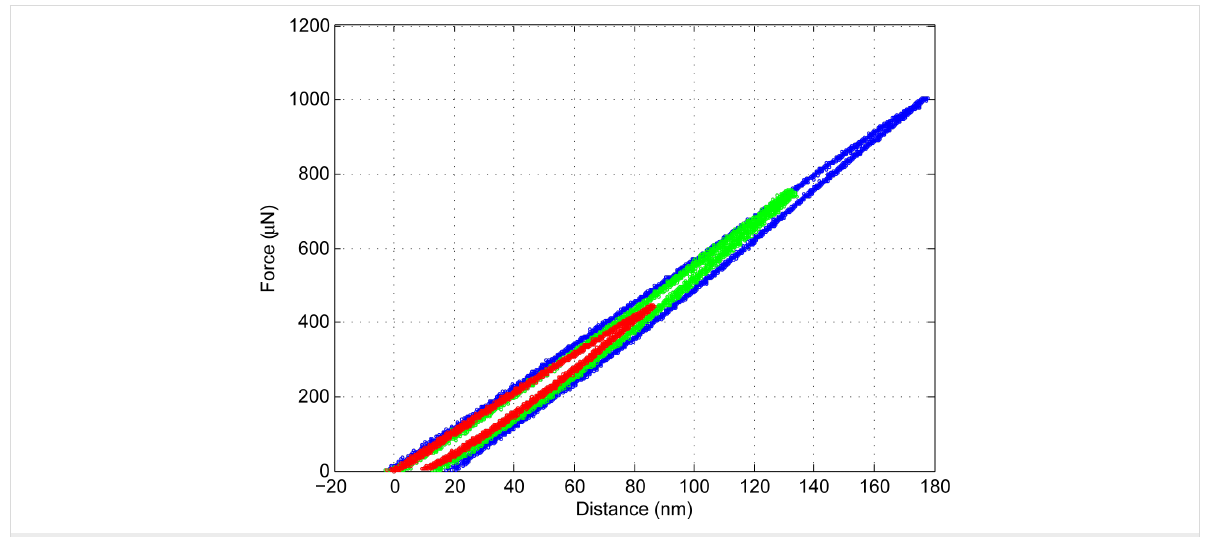
Figure 11: Force–distance curves on silicon substrate.